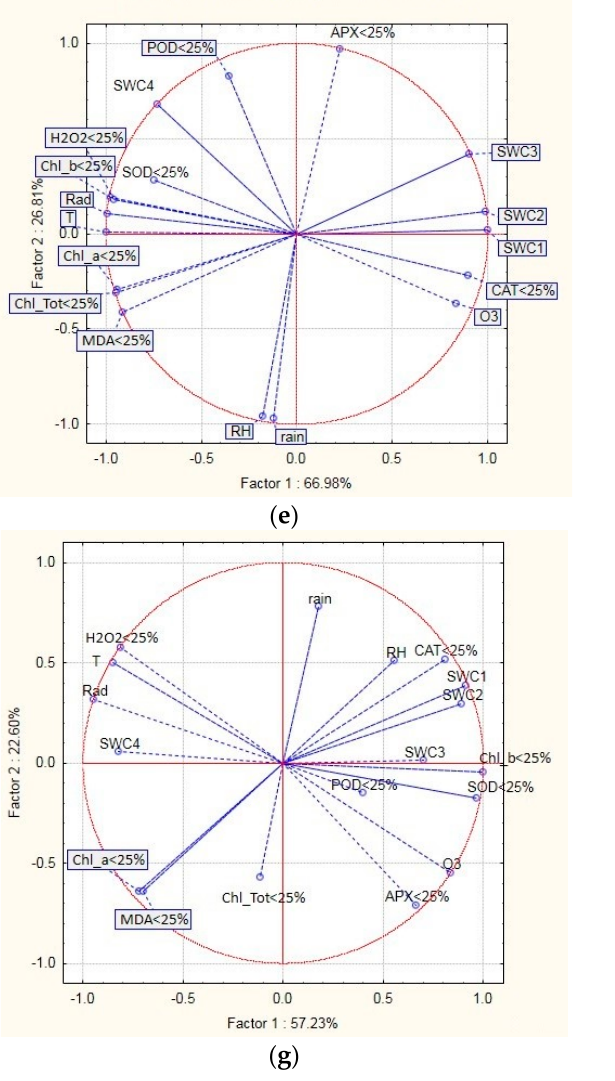
Figure 2. Principal component analysis (PCA) biplot of the physiological data and environmental variables for undefoliated (<25%) and defoliated (>25%) trees in four Mediterranean forest species: ( a ) pubescent oak (<25%); ( b ) pubescent oak (>25%); ( c ) holm oak (<25%); ( d ) holm oak (>25%); ( e ) Aleppo pine (<25%); ( f ) Aleppo pine (>25%); ( g ) black pine (<25%); ( h ) black pine (>25%).